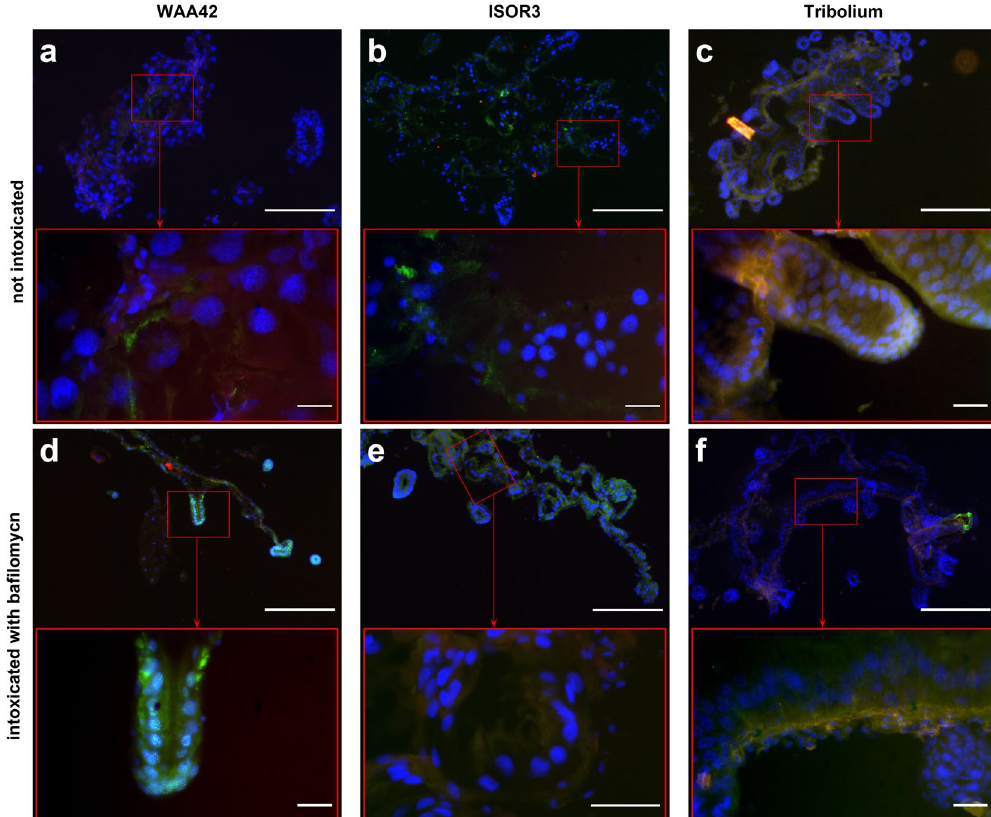
Figure 9. Immuno-localization of the caspase-3 active form in sensitive S. oryzae (strain WAA42), in resistant S. oryzae (ISOR3), and in insensitive T. castaneum intoxicated with bafilomycin. Midguts of insects were dissected, embedded, frozen and then tissue sections (7 µ m) were cut. Slides were prepared as described in the Experimental Procedures section. Caspase-3 was labelled with rabbit anti-cleaved caspase-3, and revelation was performed using a secondary antibody Alexa fluor 488 donkey anti-rabbit IgG. DAPI was added for nuclear staining. The S. oryzae PA1b sensitive strain (WAA42), the resistant (ISOR3) strain, and the insensitive insect T. castaneum were all reared on non-intoxicated medium (panel a,b and c, respectively) or on the same medium containing bafilomycin (150 µ g per g of food) (panel d, e, and f, respectively). Upper panel scale bar = 200 µ m; lower panel scale bar = 20 µ m. Blue: nuclei stained with DAPI; green: caspase 3; brownish-red: non-specific signal from background